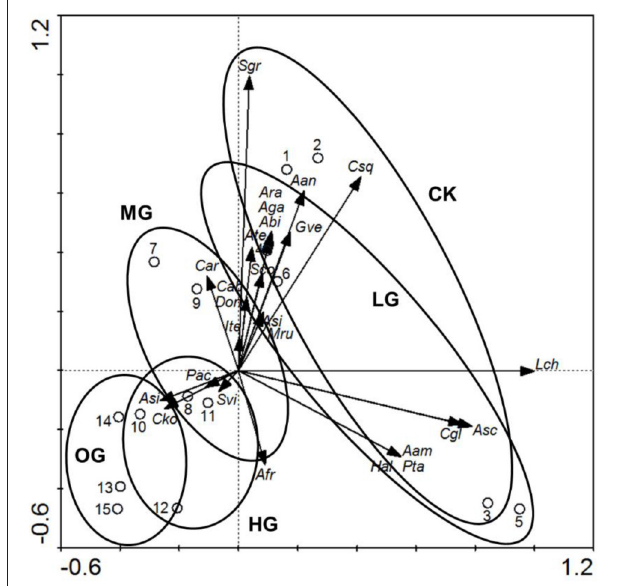
FIGURE 1 | The ordination triplot of sample plots-plant species-grazing intensities. Arrows indicate plant species biomass. Ellipses indicate livestock grazing intensities. Open circles with numbers indicate plot numbers within grazing intensity. CK, control (no grazing); LG, light grazing (3 sheep/hectare); MG, moderate grazing (6 sheep/ hectare); HG, heavy grazing (9 sheep/ hectare); OG, overgrazing (12 sheep/ hectare). Plant name abbreviations are listed in Supplementary Table